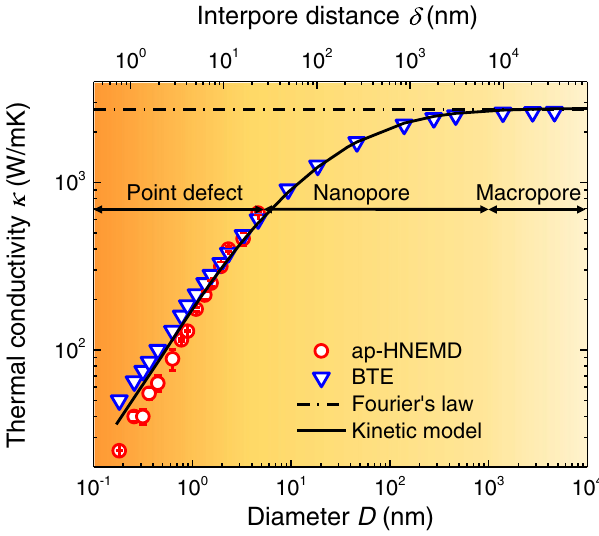
Fig. 5 Thermal transport regimes of point defect, nanopore, and macropore. The thermal conductivities of porous graphene with different pore sizes are calculated by phonon BTE and predicted by the kinetic model. The thermal conductivity of macroporous graphene is calculated based on Fourier ’ s law. For the point defect regime, the thermal conductivities computed by MD simulations have been presented in Fig. 4f, which are shown here for reference. The three regimes are divided by two critical pore sizes of 5 nm and 1 μ